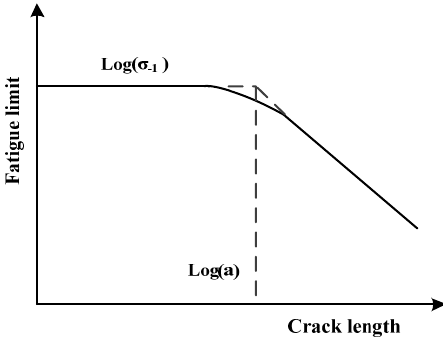
Figure 6. KT (Kitagawa-Takahashi) diagram.